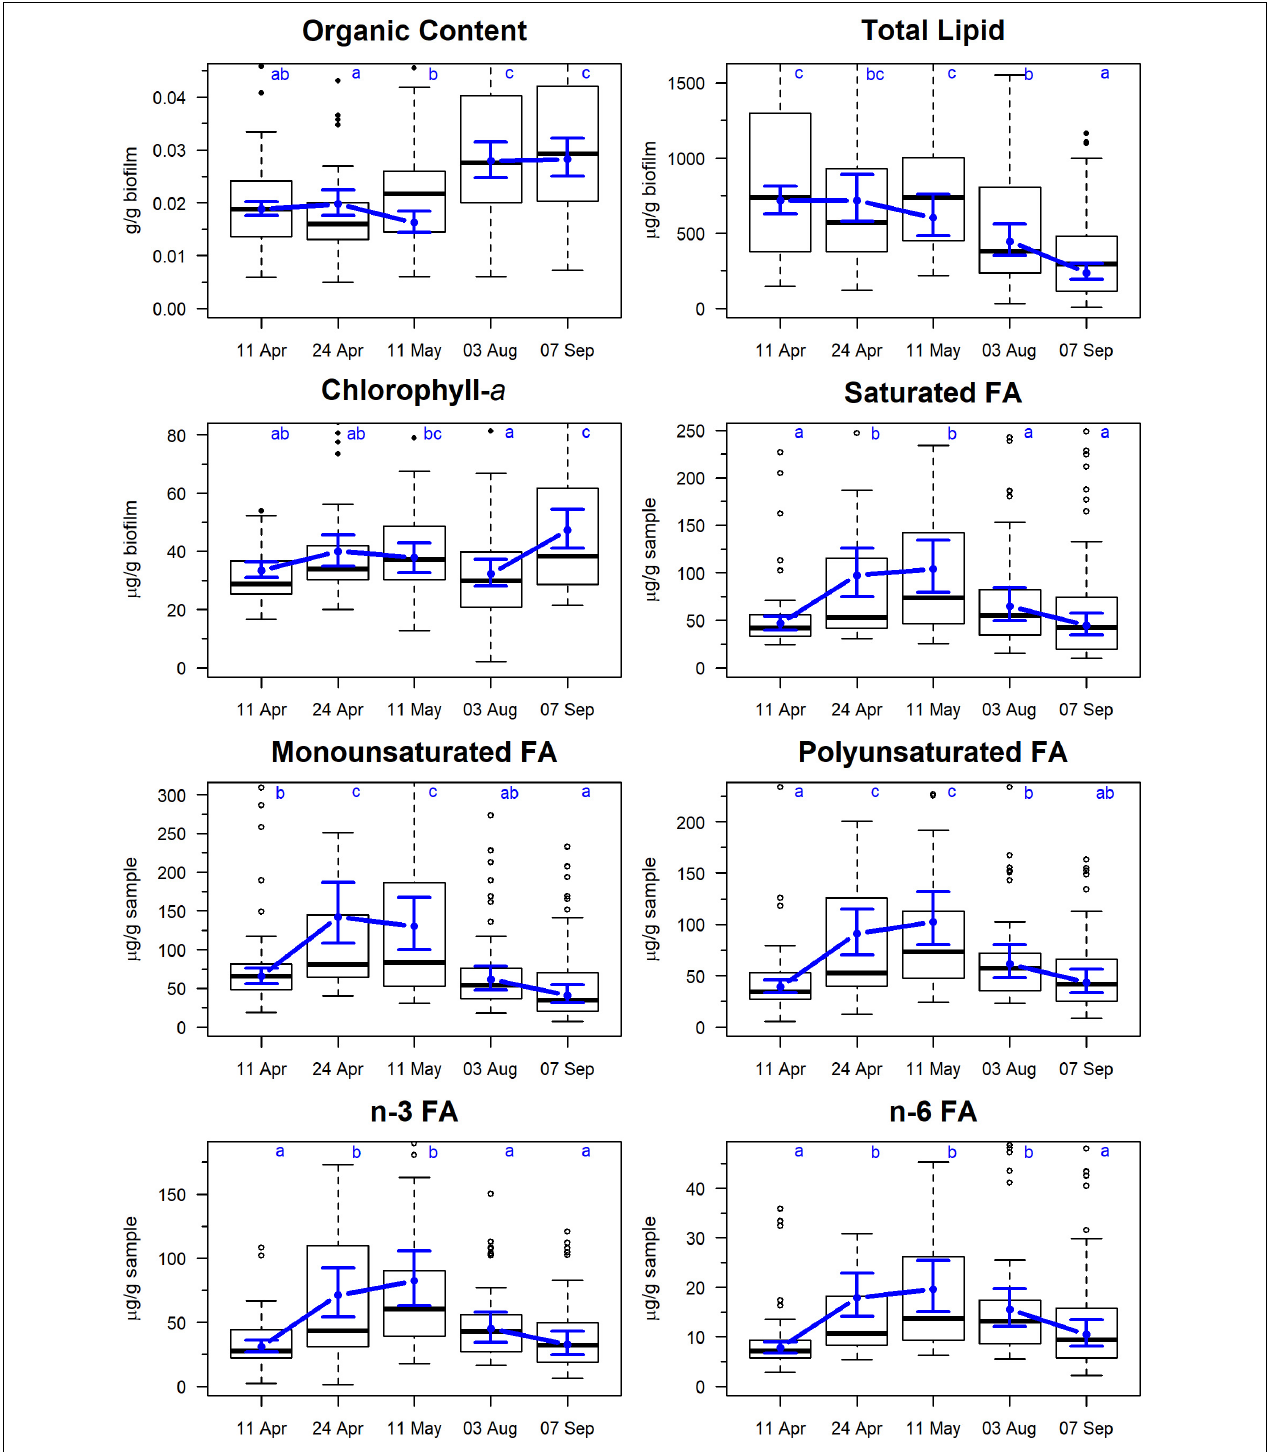
FIGURE 2 | Temporal changes in biofilm measures on Roberts Banks mudflats located on the Fraser River estuary, British Columbia, April-September 2017. Biofilm measures are expressed in units of per 1 g of sample, including inedible sediment. Note that y -axis extends from 0 to 0.90 percentile of each measure to avoid compression of scale from outliers. Box plots represent the distribution of observed values, where midline is the median, with the upper and lower limits of the box being 75th and 25th percentiles. Whiskers extend up to 1.5 × the interquartile range, and outliers are depicted as points. Blue circles indicate predicted means from linear mixed effects models, and bounds are 95% predictions intervals from fixed effects. Letters indicate groupings that are not statistically significantly different according to Tukey’s pairwise comparisons.